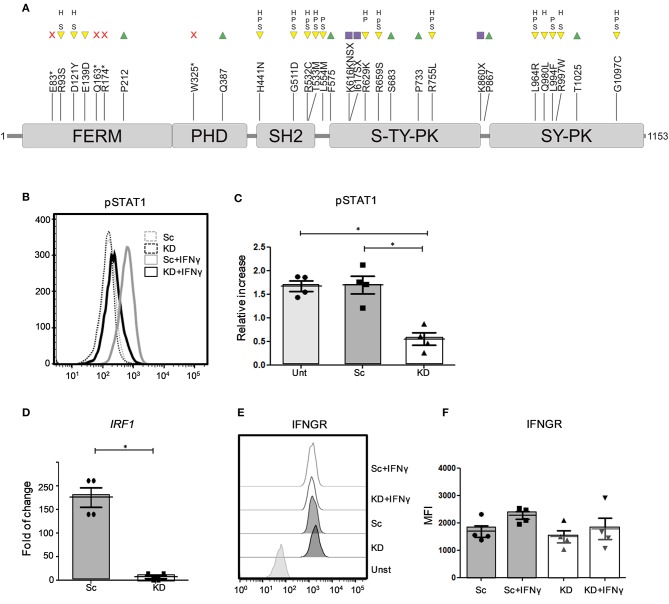
STAT1 phosphorylation and expression of IRF1 mRNA is impaired in JAK1-deficient hTERT urothelial cells. (A) JAK1 protein (InterPro P23458) structure showing core domains, TCGA BLCA variants and their predicted impact. Protein domains: FERM (4.1 protein, ezrin, radizin, moesin domain), PHD (pleckstrin homology-like domain), SH2 (Src homology 2), S-TY-PK (unknown specificity serine-threonine/tyrosine protein kinase), SY-PK (serine-tyrosine protein kinase). Variants: non-sense (red cross), missense (yellow inverted triangle), synonymous (green triangle), frameshift (purple square). Variant effects: S (SIFT score < 0.05), P (Poly-Phen score > 0.908), p (Poly-Phen score > 0.446 & ≤ 0.908), H (HMMvar score > 2). A single 5′ UTR modifier mutation not shown. (B,C) Analysis of JAK/STAT signaling by flow cytometry in untransduced (Unt), Sc and KD hTERT immortalized urothelial cell lines after stimulation with IFNγ (1 ng/ml) for 24 h. Data (A) is from a representative experiment, data (B) is from three independent experiments. Two-tailed Mann Whitney test. (D) RTqPCR analysis of IRF1 mRNA expression from KD and Sc hTERT immortalized urothelial cell lines after stimulation with IFNγ (1 ng/ml). Data is from four independent experiments. Two-tailed Mann Whitney test.*P < 0.05 Error bars represent the SE. (E,F) Flow cytometry analysis of IFNGR expression in KD and Sc hTERT immortalized urothelial cell lines following stimulation with IFNγ (5 ng/ml) for 2 days. The graph shows mean values ± SD. Data is from three independent experiments. One-way ANOVA with Tukey's Multiple Comparison Test.